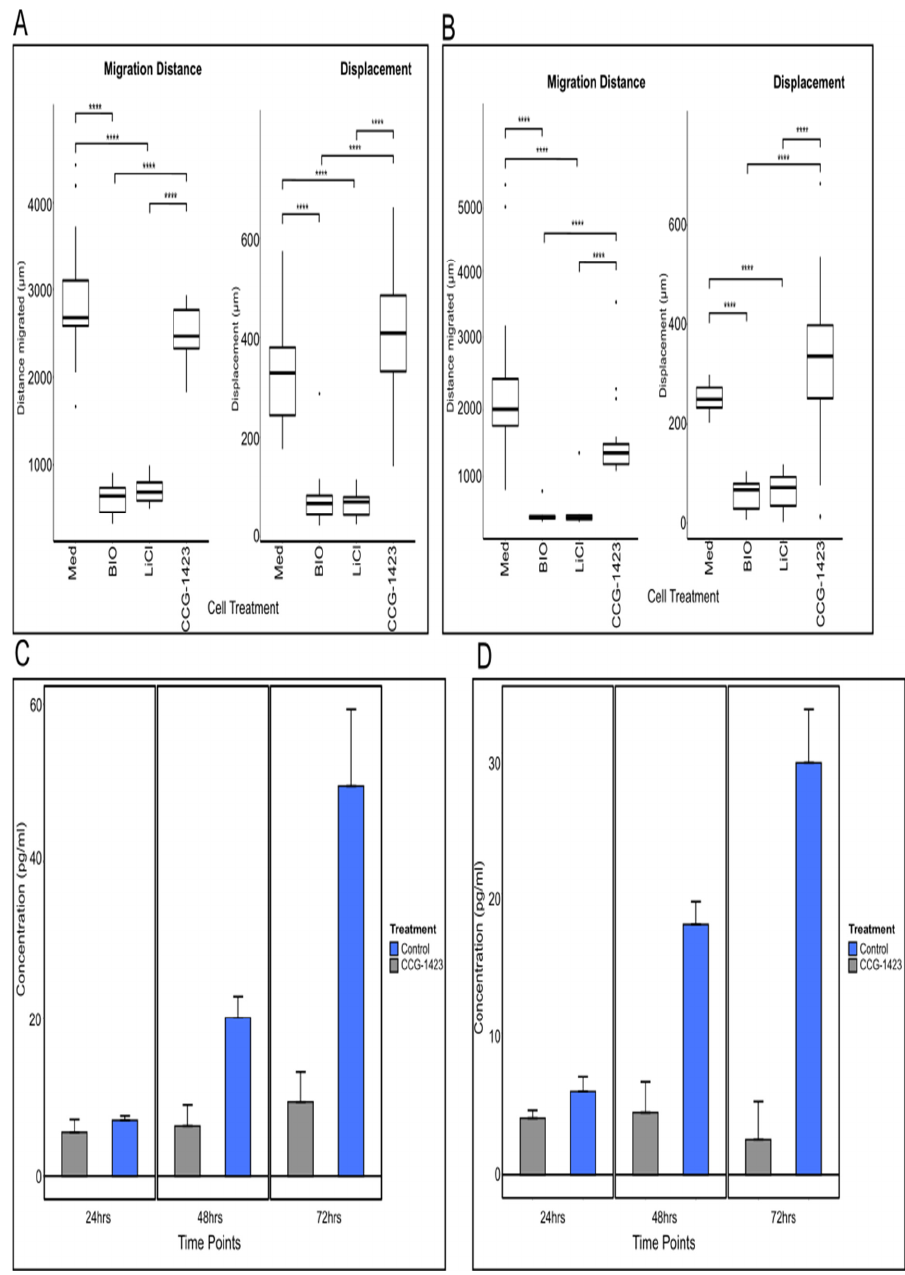
Figure 2. Effect of CCG-1423 on cell migration and CCNI secretion. The effects of inhibitors on cell migration as measured by distance travelled and cell displacement in ( A ) U251 and ( B ) U87 cell lines. Experiments were repeated in triplicate. For sample specific tracking examples see Supple- mentary Figure S2B. Asterisks indicate statistically significant results compared to the control (Med). **** p ≤ 0.0001, Kruskal–Wallis for A, Distance: p = 4.18 × 10 − 13 , Displacement: p = 1.52 × 10 − 12 ; for B, Distance: p = 6.62 × 10 − 13 , Displacement: p = 2.17 × 10 − 10 . An ELISA was carried out to determine CCN1 levels in the supernatants of ( C ) U251 and ( D ) U87 cell lines over a 72-h period. Cells were incubated for 24, 48 and 72 h +/ − CCG-1423. The supernatants were collected for each time point and tested for CCN1 by ELISA. The results suggest reduced CCN1 concentration levels in the supernatants of treated U251 and U87 cells, at the 48 and 72-h time points, when compared to the untreated controls as indicated by decreased concentration. Significant differences were marked in the graphs when available. **** p ≤